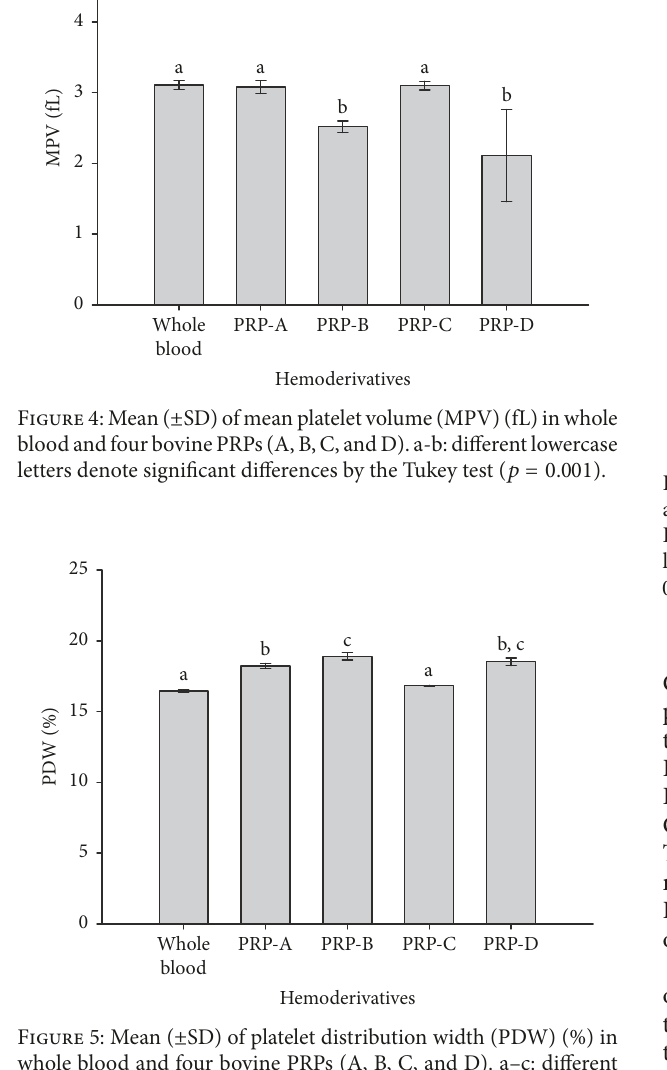
Figure 5: Mean ( ± SD) of platelet distribution width (PDW) (%) in whole blood and four bovine PRPs (A, B, C, and D). a–c: different lowercaselettersdenotesignificantdifferencesbytheTukeytest( 𝑝 = 0.001 ).